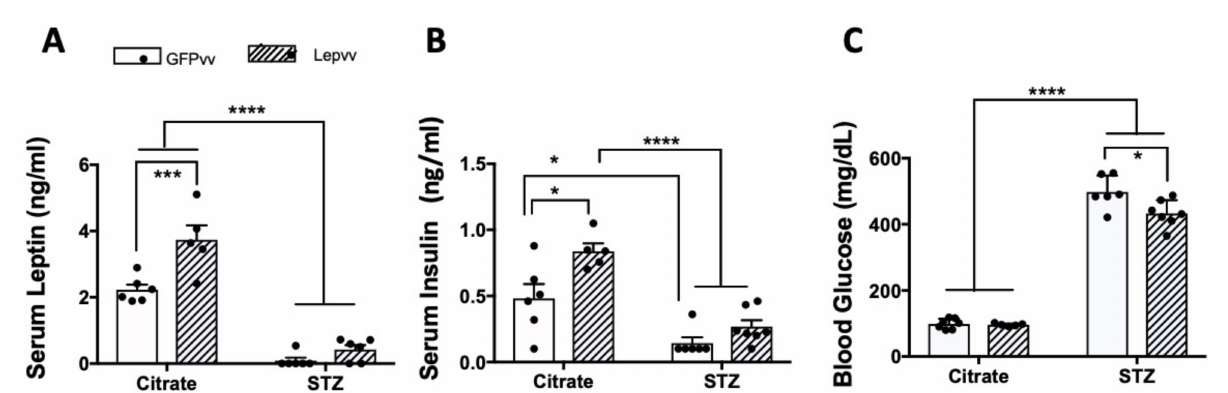
Figure 4. Changes in serum leptin (panel ( A )), serum insulin (panel ( B )) and blood glucose levels (panel ( C )) in male rats that were injected with Lepvv or GFPvv followed by injection with citrate buffer or STZ (to induce diabetes). Citrate + GFPvv ( n = 7); STZ + GFPvv ( n = 6); Citrate + Lepvv ( n = 5) and STZ + Lepvv ( n = 7) are represented. Data were analyzed by 2-way ANOVA followed by Tukey’s multiple comparisons test. * indicates p < 0.05; *** indicates p < 0.001; **** indicates p <